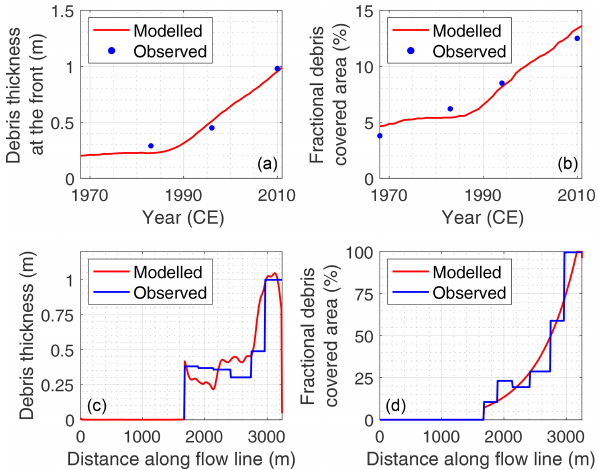
Figure 5. Calibrated supraglacial debris cover model for the Djankuat Glacier, showing the observed and modelled temporal evolution of (a) debris thickness at the front and (b) the glacier- wide fractional debris-covered area, as well as observed and mod- elled (c) debris thickness and (d) debris-covered area along the flow line for 2010CE conditions. Observed data from (a) – (c) are from Popovnin et al. (2015), whereas the observed debris-covered area in (d) was derived by manually digitizing debris-covered patches along the flow line using 2010CE satellite imagery in Fig. 1.